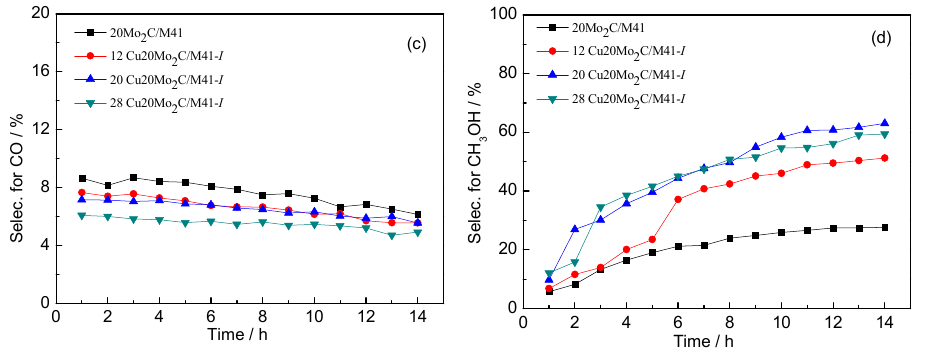
Figure 7. Catalytic performance of x Cu20Mo 2 C/M41 ‐ I in CO 2 hydrogenation. ( a ) CO 2 conversion; ( b ) CH 4 selectivity; ( c ) CO selectivity; ( d ) CH 3 OH selectivity. Reaction conditions: catalyst 0.5 g, temperature 493 K, pressure 3.0 MPa (H 2 :CO 2 = 3:1), GHSV 3600 mL/(h ∙ g).